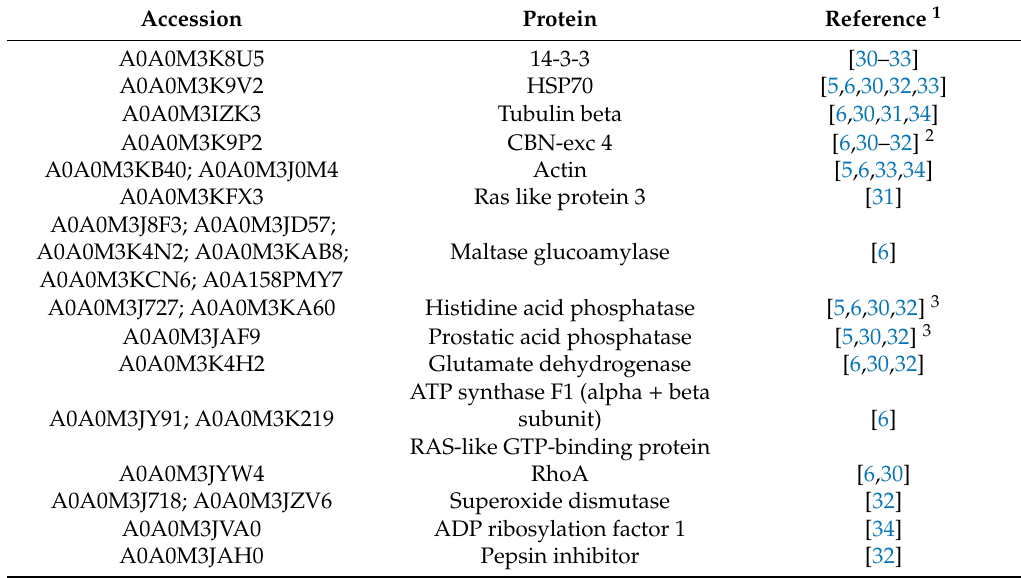
Table 1. Identified Anisakis spp. EV proteins cross-referenced to published helminth EV